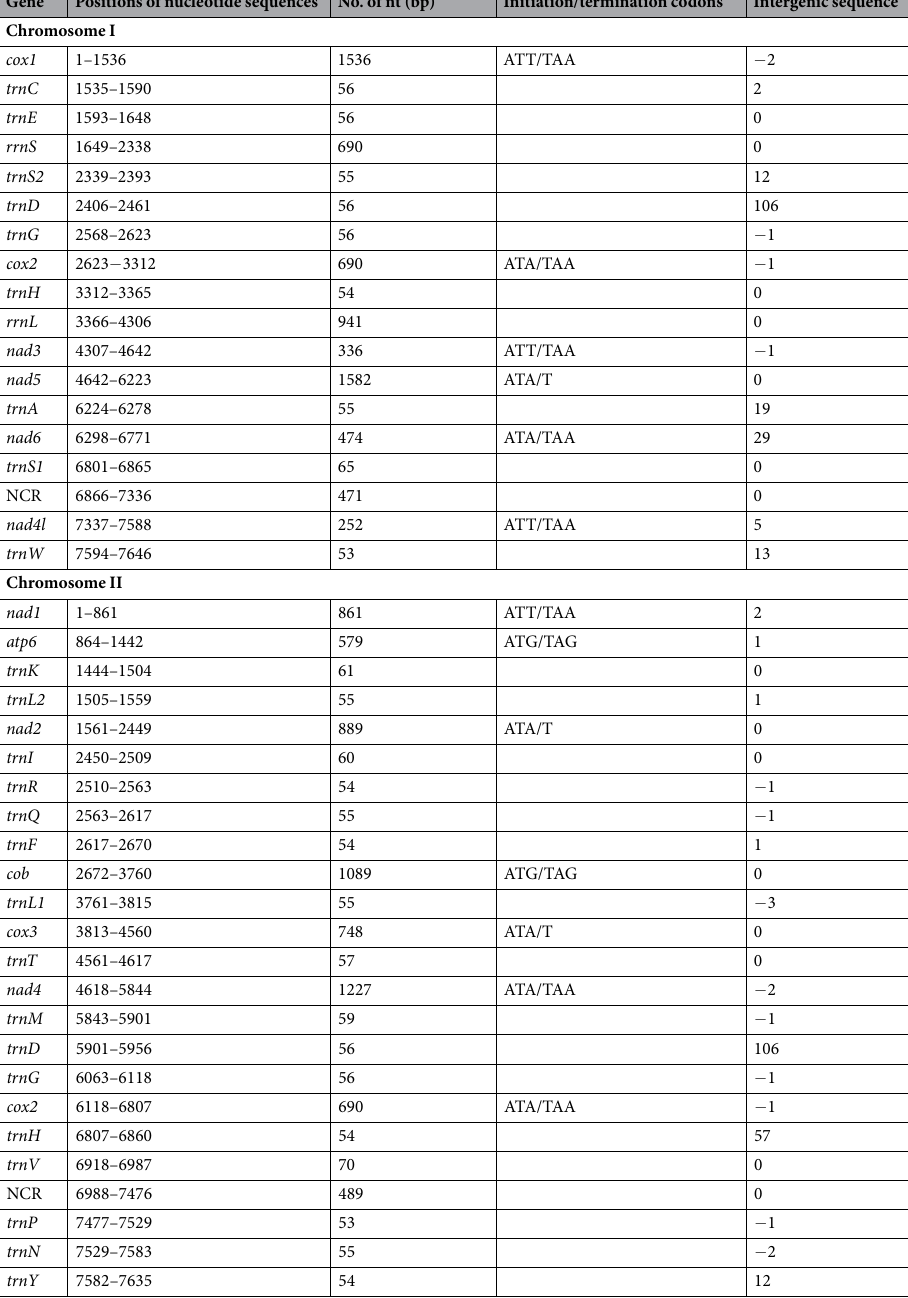
Table 1. Mitochondrial genome organization of Ruizia karukerae